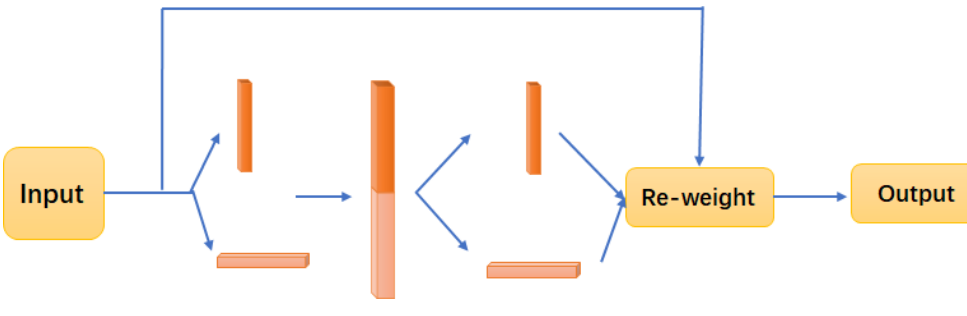
Figure 3. Coordinated attention